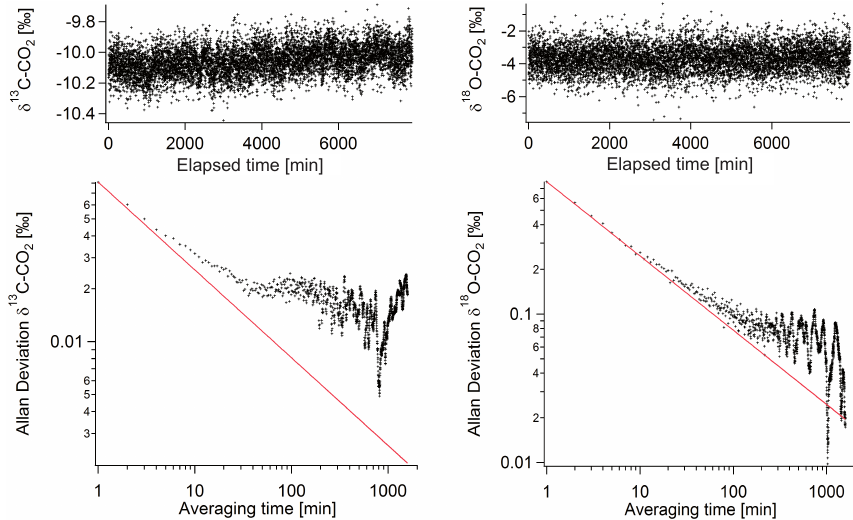
Figure 4. Allan deviation of δ 13 C-CO 2 (left) and δ 18 O-CO 2 (right) measured over the course of 6 days in September 2011 with the FTIR.